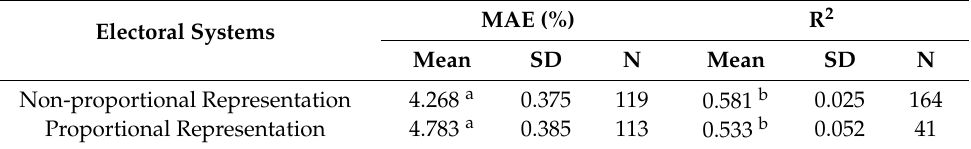
Table 6. Covariate-adjusted means of predictive power across electoral